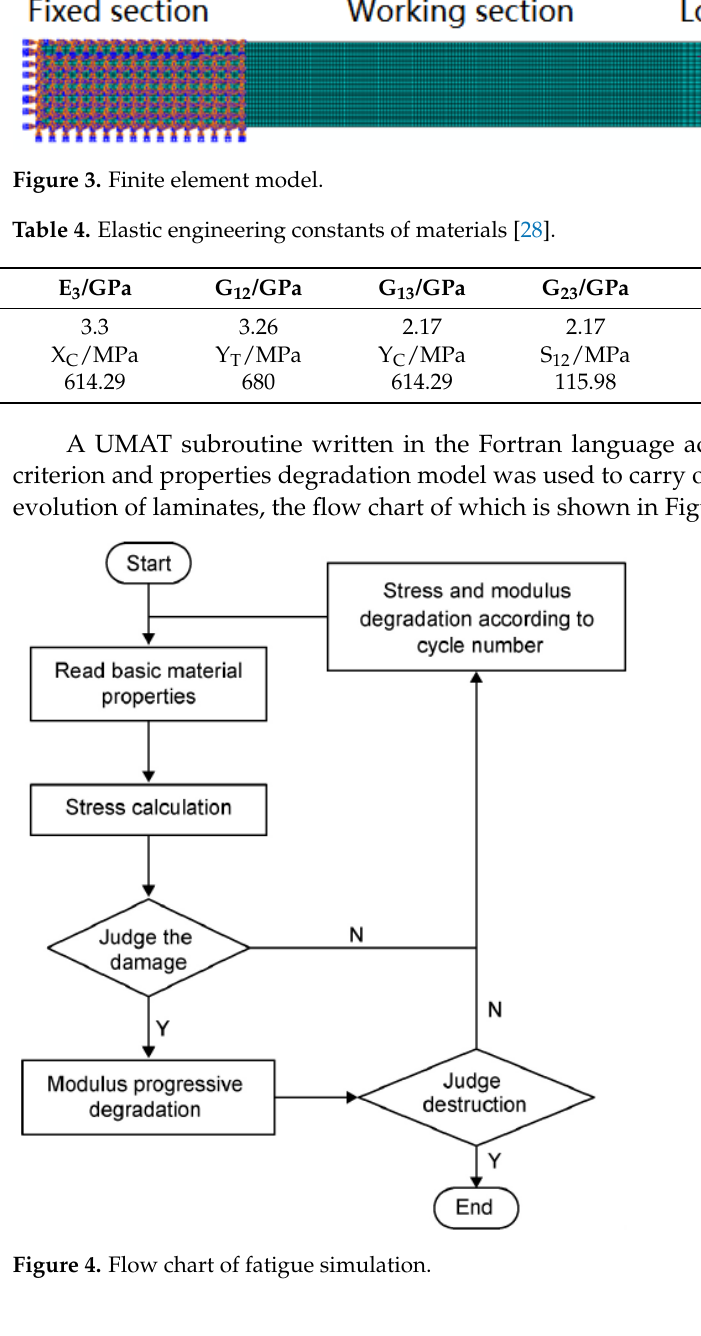
Figure 4. Flow chart of fatigue simulation. 4. Results and Discussion 4.1. Tensile Tests The average tensile properties in three environments are shown in Table 5. It can be found that, compared with the elastic modulus and tensile strength in RTD, they increase by 12.67% and 12.84%, respectively, in CTD, and decrease by − 8.54% and − 37.11%, re- spectively, in ETW. Therefore, it can draw a conclusion that the increase in matrix brit- tleness at cool temperature increases the elastic modulus and tensile strength corre- spondingly, while the coupling effect of high temperature and high moisture seriously weakens them.